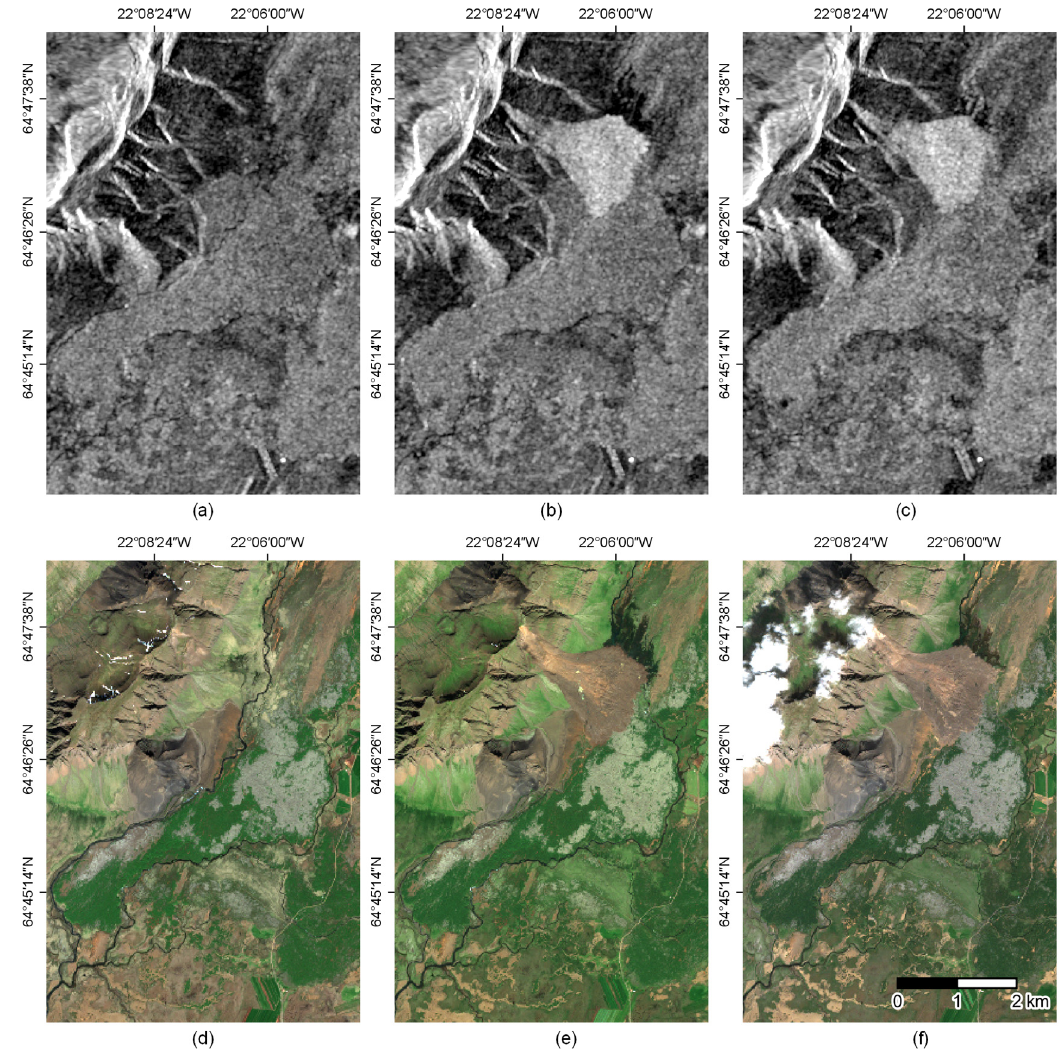
Figure 3. Sentinel-1 and Sentinel-2 datasets used for geomorphological features mapping. The upper row shows the intensity layer for Sentinel-1 vertical-vertical (VV) polarization for the following image acquisition dates: ( a ) 5 July 2018; ( b ) 17 July 2018; ( c ) 5 August 2019. The lower row shows the true color composites of the Sentinel-2 images with the following acquisition dates: ( d ) 20 June 2018; ( e ) 17 July 2018; ( f ) 1 August 2019.